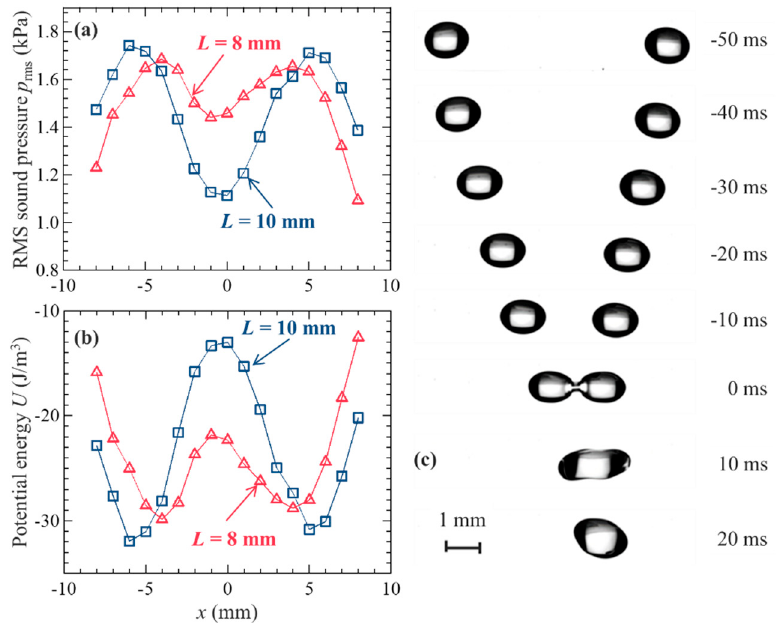
Figure 2. Coalescence procedure and visualization of droplets: ( a ) RMS sound pressure and ( b ) acoustic potential energy distributions for L = 8 and 10 mm, as shown in Figure 1b. ( c ) Droplet coalescence procedure in an acoustic field. The droplets coalesced when the distance between them decreased from L = 10 to 8 mm; 0 ms indicates the moment the droplets make contact.